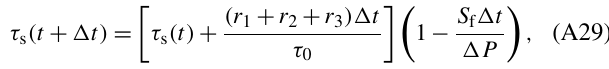
Table A1. Ground layer depths and thicknesses for the 20 ground layers